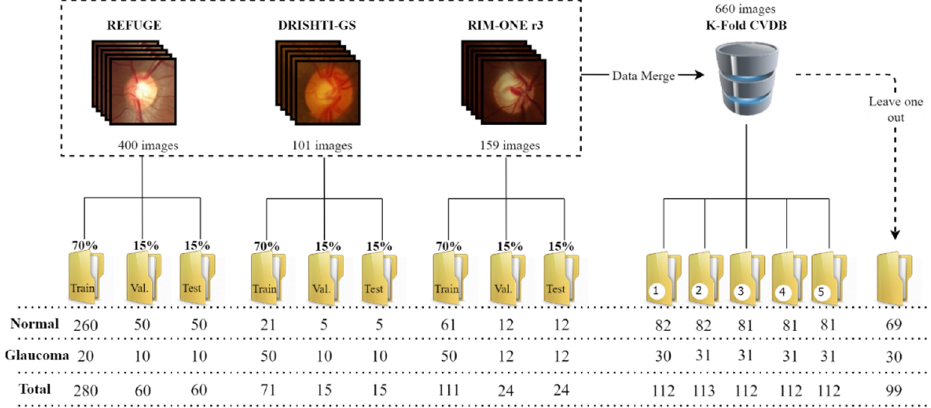
Figure 5. Data organisation for training the models.